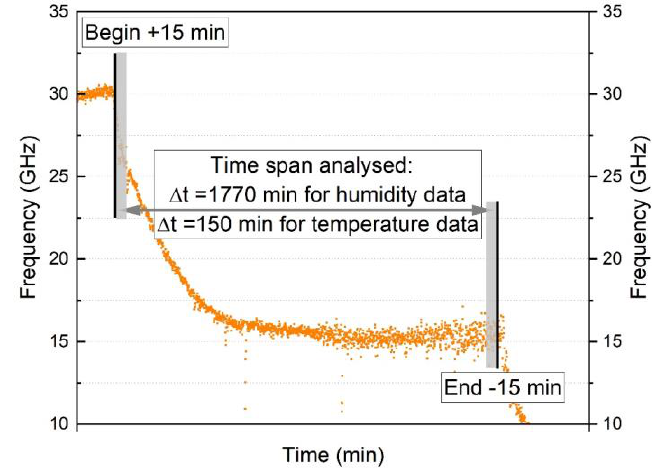
( c ) Figure 9. Length stability of the 2.0 TBC cable exposed to different temperature levels. ( a ) frequency shift versus cable position during heating and cooling ( b ) shifts associated with three time points at 50 °C during heating ( c ) shifts associated with three time points at 50 °C during cooling. 4.2. Frequency Drift with Time and Temperature The time- and temperature-dependent frequency drift under constant exposure con- ditions was assessed by selecting data using the sampling time increment of 1 min. An example of the resulting data is shown in Figure 10. Since transient frequency spikes were often observed at the beginning of each temperature step (see also Figure 8b,c), the read- ings from 0 – 15 min and 165 – 180 min were disregarded. The frequency readings during the period from 15 – 165 min (150 data points) were averaged to obtain the mean frequency for a given sustained temperature. In addition, the readings at 1 min intervals between 15 – 25 min and also between 155 – 165 min were averaged and compared to provide an indication of the magnitude of the frequency drift with time. The time spans of 10 min which were averaged are shown indicatively in Figure 10 as grey areas. To provide a bet- ter indication of the measurement parameters of interest, the average frequencies and fre- quency drifts were converted to temperatures using the average calibration factor shown in the 6 th column in Table 4 for a given cable type. This was done for 3 different locations along the cable length, as summarised in Table 6. The length analysed was typically 6000 mm, with the exception of the bare fibre (2500 mm) and the 0.9 mm TBC cables (4000 mm)